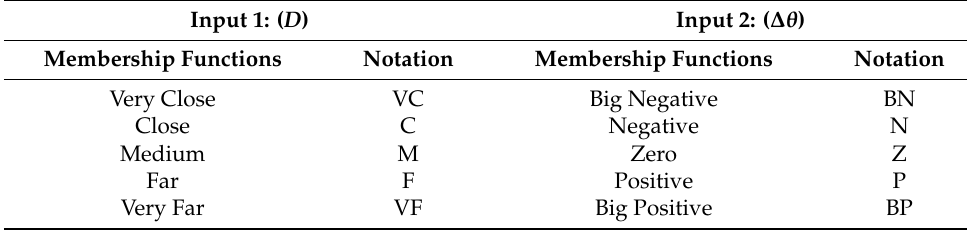
Figure 9. Representation of membership functions of each input and output. Table 2. The input membership functions.